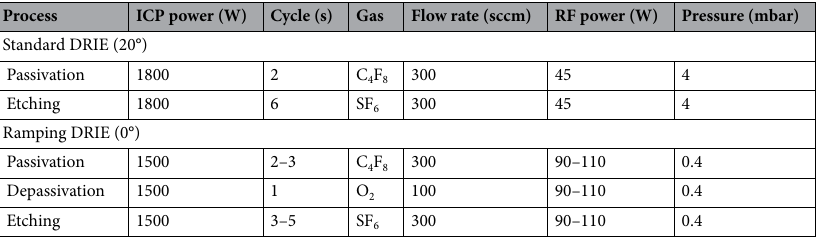
Table 1. Parameters of the DRIE etching process.